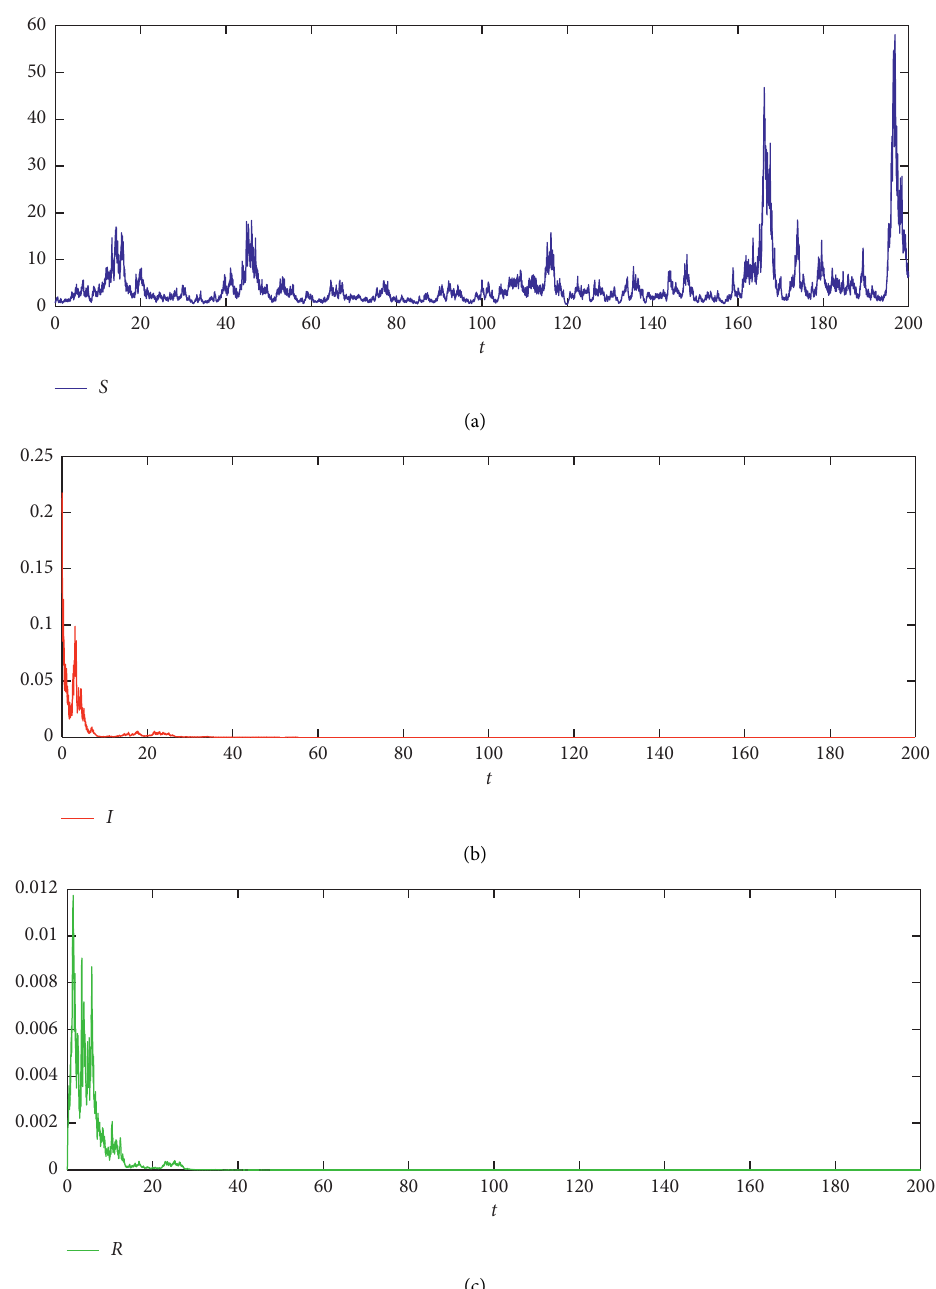
Figure 2: The solution (S(t), I(t), and R(t)) of stochastic model (3) with (S(0), I(0), and R(0) � (0.7, 0.2, and